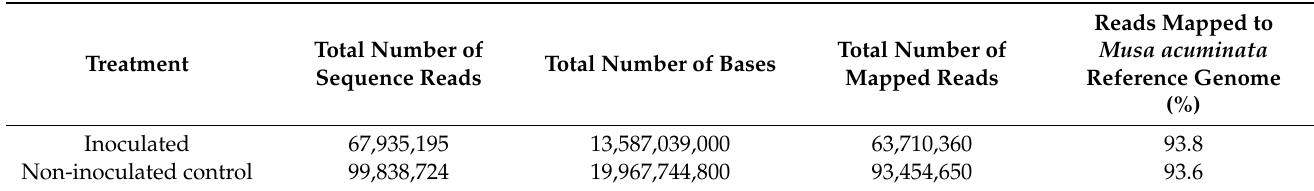
Table 2. Overview of filtered Illumina HiSeq 4000 sequence reads per treatment mapping to the Musa acuminata DH-Pahang reference